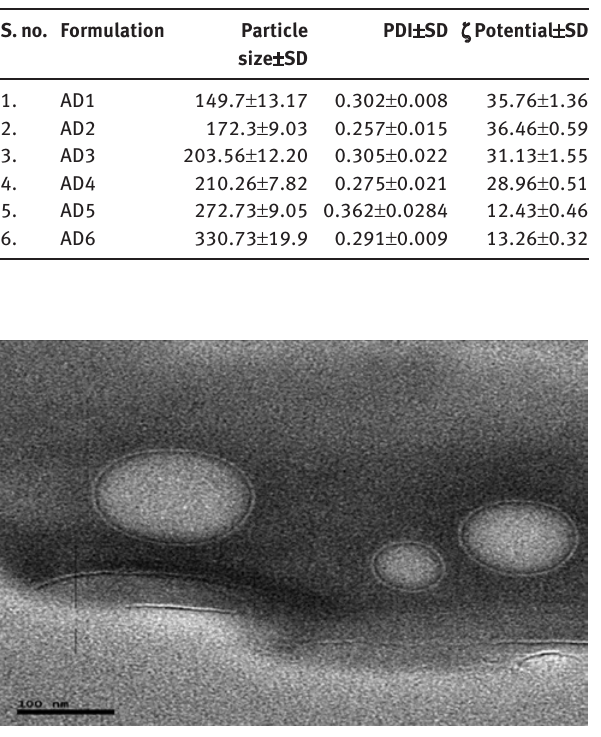
Figure 2: TEM image of the optimized nanoformulation.